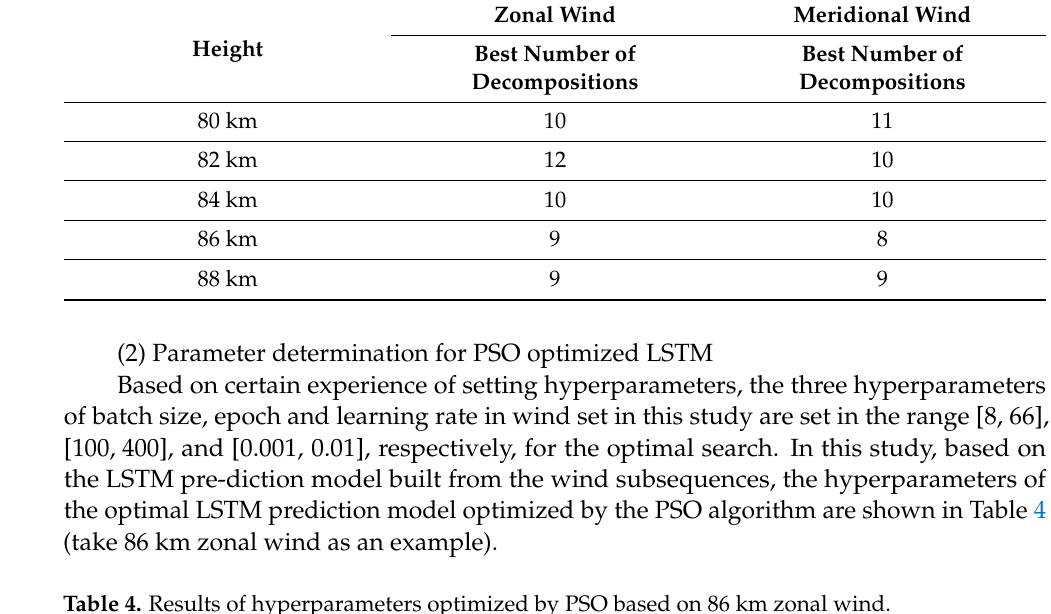
Table 4. Results of hyperparameters optimized by PSO based on 86 km zonal wind. 86 km Zonal Wind Batch_Size